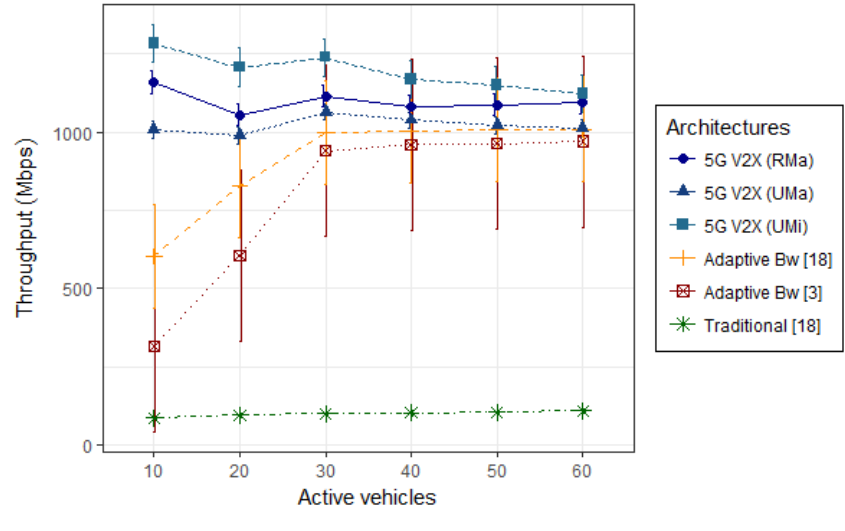
Figure 7. Network